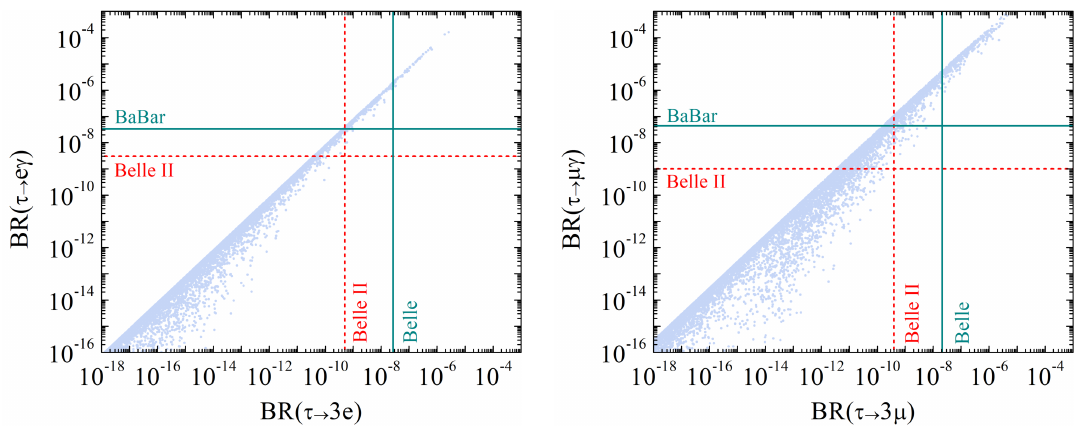
Figure 8 . On the left [right] we present the BR( τ → eγ ) [ BR( τ → µγ ) ] in terms of BR( τ → 3 e ) [ BR( τ → 3 µ ) ]. These cLFV observables are allowed for the Z e − τ the same colour code used in figure 6 and 7 to indicate the current bounds and projected